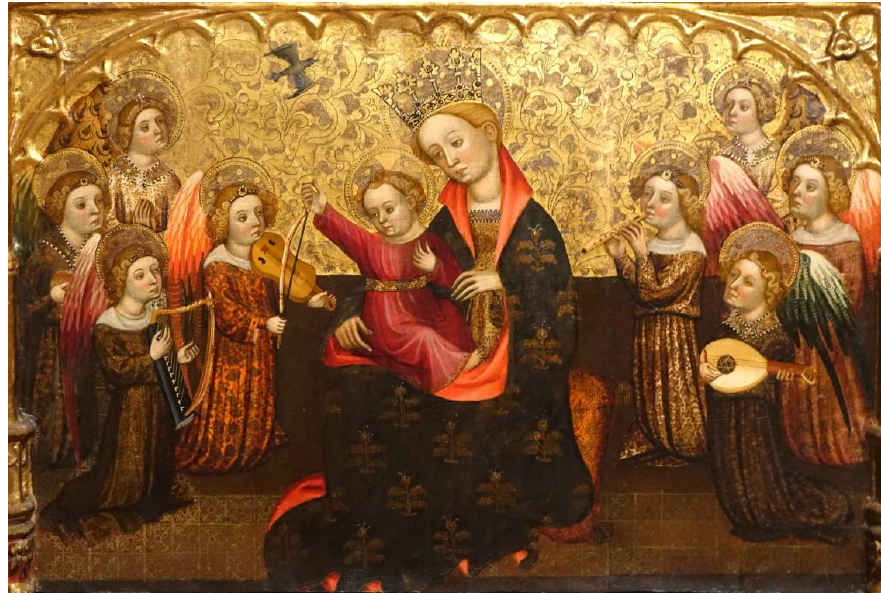
Figure 10. Madonna of Humility and musician angels , Jaume Cabrera, last quarter of the 14th century and first quarter of the 15th century, Museu episcopal de Vic, MEV 1948.